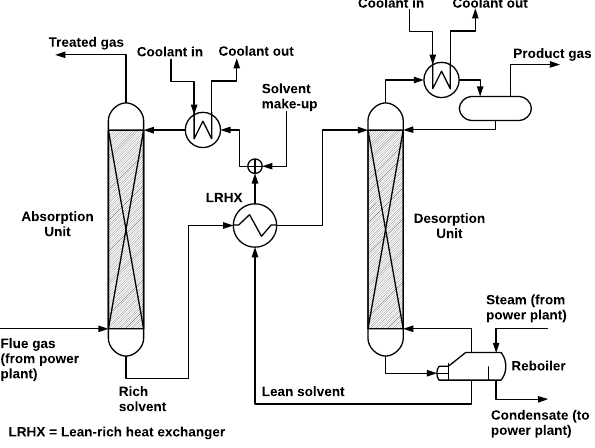
Figure 2. Schematic diagram of a full cycle amine-based post-combustion capture